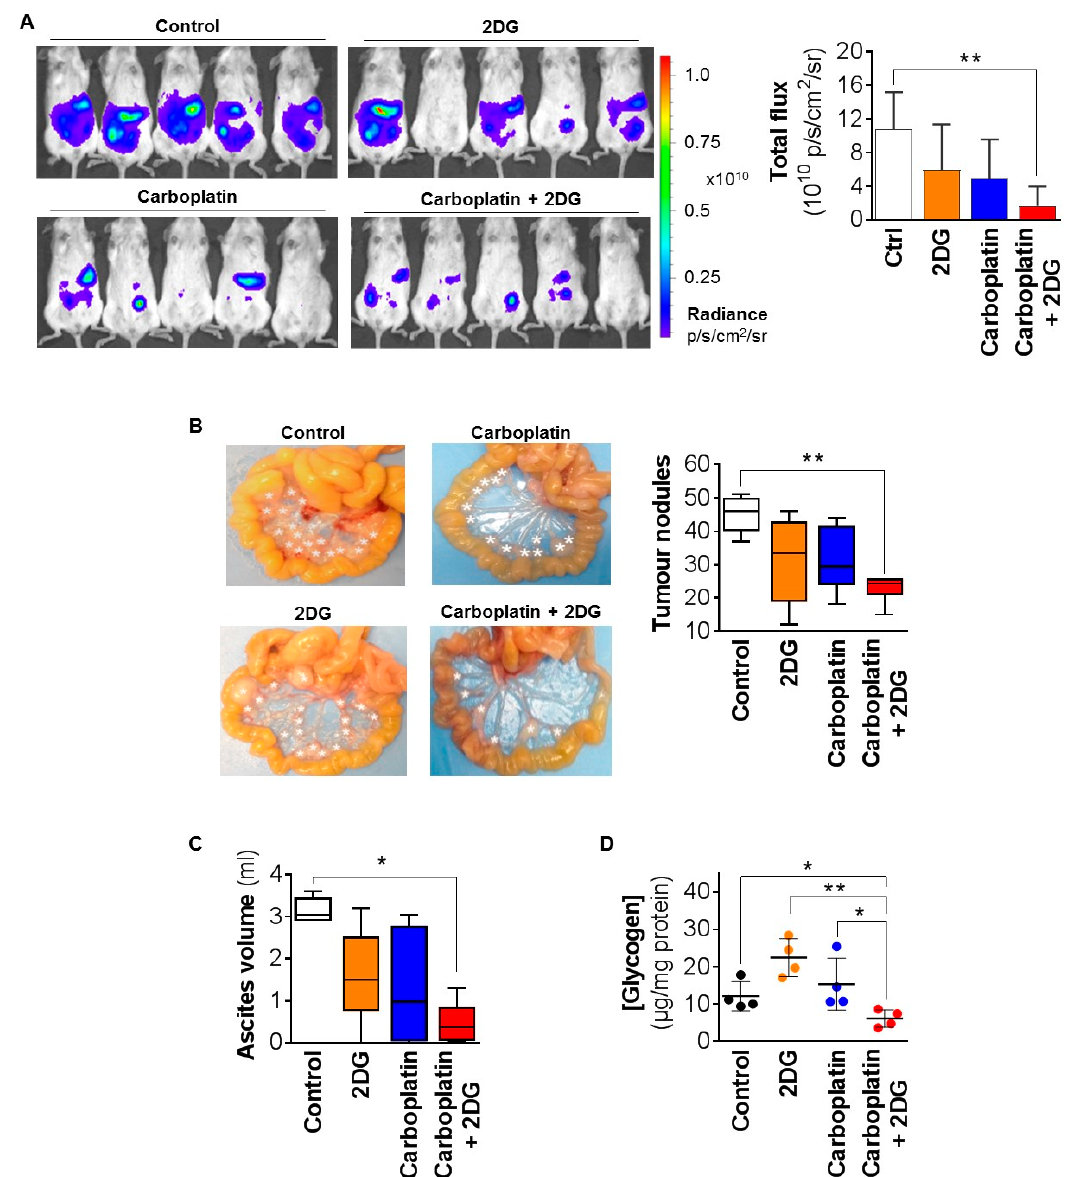
Figure 4. Combined with carboplatin, 2DG reduces the tumor burden of TOV21G cell line xenografts. Luciferase-labelled TOV21G cells (2 × 10 5 ) were injected intraperitoneally (i.p.) into female NSG mice, with treatment starting two weeks later with PBS (control), 2DG (50 mg / kg / week), carboplatin (10 mg / kg / week), or a combination 2DG and carboplatin. Bioluminescent tumor burden was measured weekly with mice sacrificed at day 37. ( A ) Left, representative bioluminescent images of mice. Luminescence signal is provided in radiance units (p / s / cm2 / sr). Right, graph of bioluminescence signal. ( B ) Left, representative images of mesenteric membrane of mice harvested from each group, with tumor nodules indicated by white asterisks. Right, graph of tumor nodules ≥ 8 mm 3 . ( C ) Graph of ascites volume. ( D ) Graph of glycogen content of tumors. Results are presented as mean +/ − SD. *, p ≤ 0.05; **, p ≤ 0.01.